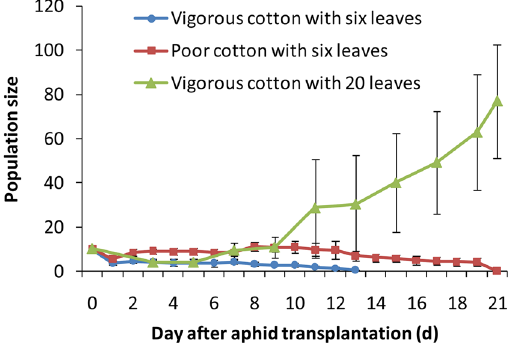
Figure 2. Population sizes (mean ± SE) of the cucurbit-specialized aphids on vigorous and poor seedling and old mature (6-month-old) cotton plants.